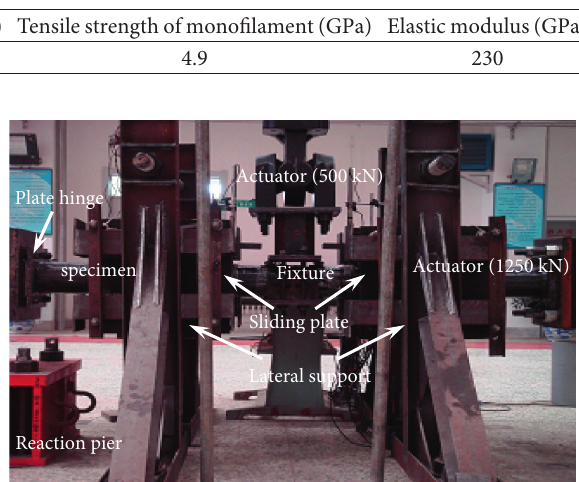
Table 3: Basic performance parameters of CFRP.